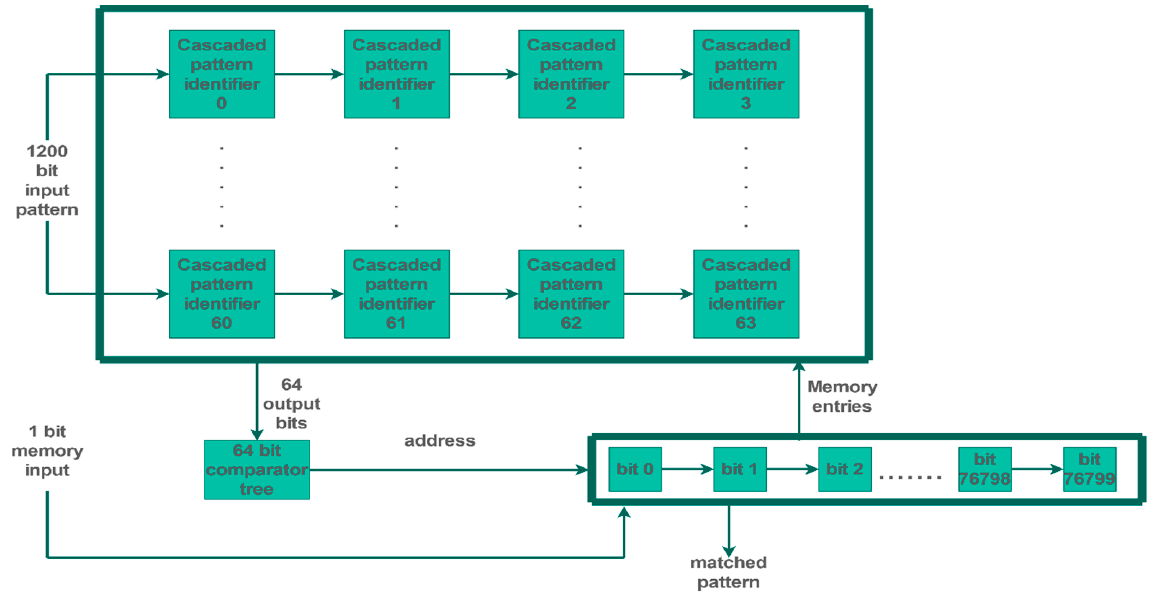
Figure 5. Pattern-matching circuit.